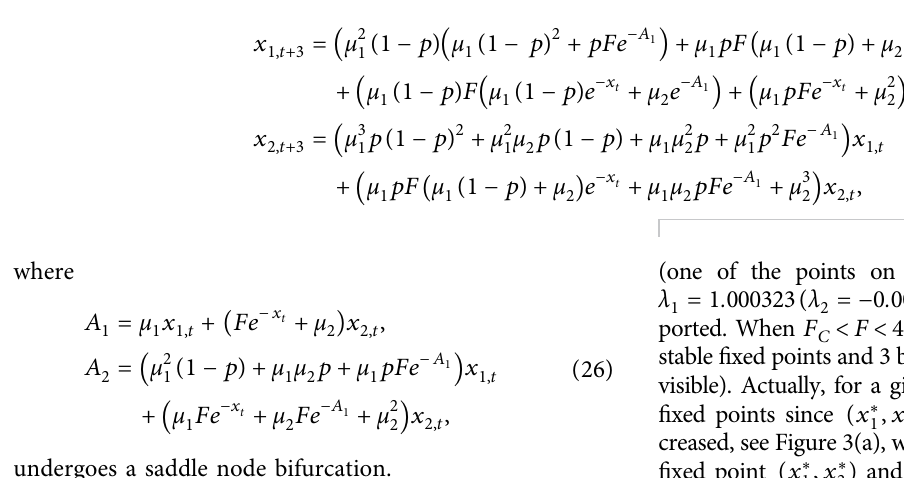
Figure 1: (a) Parameter space (shaded region) where the bifurcation is subcritical and (b) ( x ∗ F � 113 . 244, parameter values ( μ